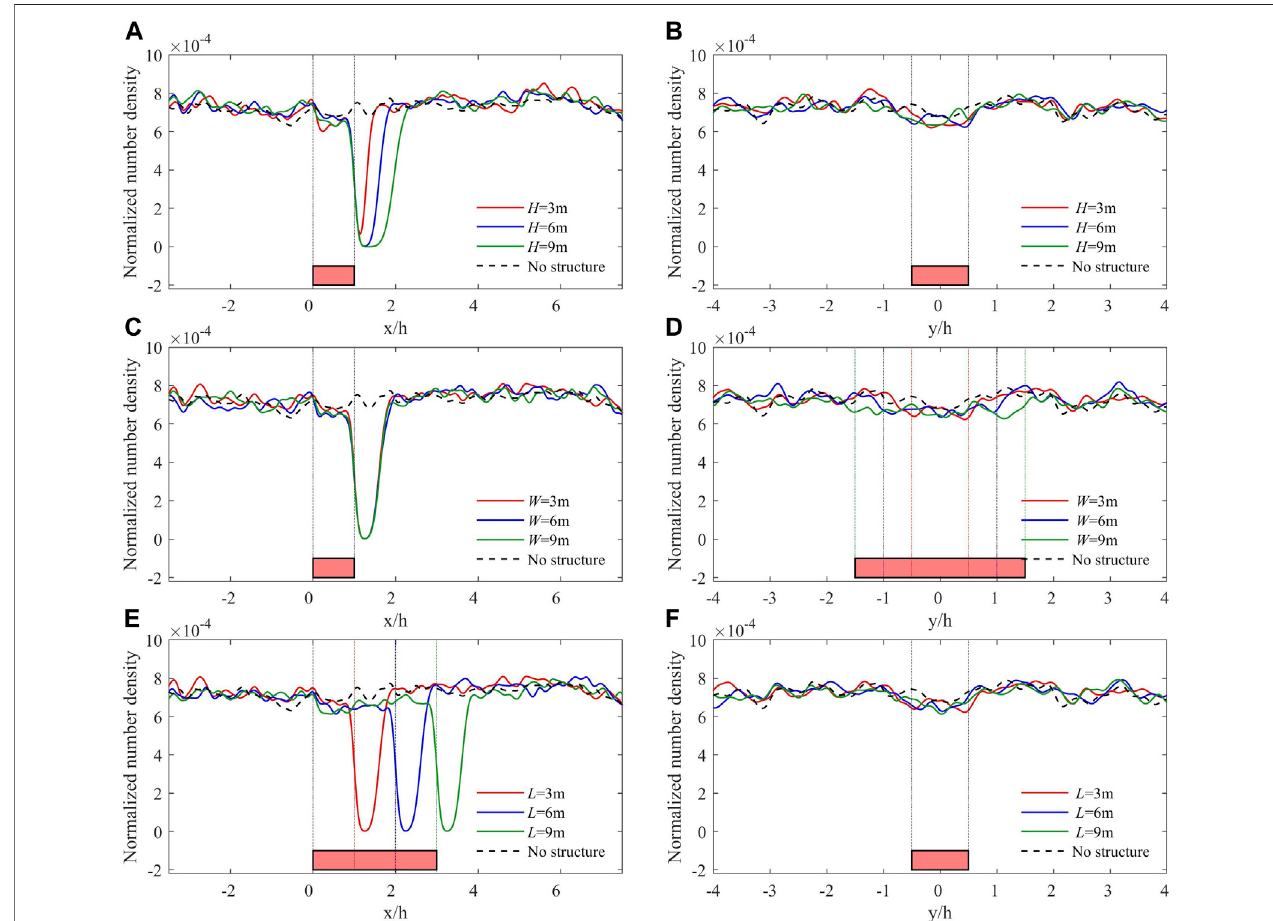
FIGURE 11 | Normalized number density of deposited fi rebrands vs. x at y (cid:3) 0 on the left panels and vs. y at x (cid:3) 0 on the right panels for (A,D) L (cid:3) W (cid:3) 3 m; (B,E) H (cid:3) 6 m and L (cid:3) 3 m; and (C,F) H (cid:3) 6 m and W (cid:3) 3 m.